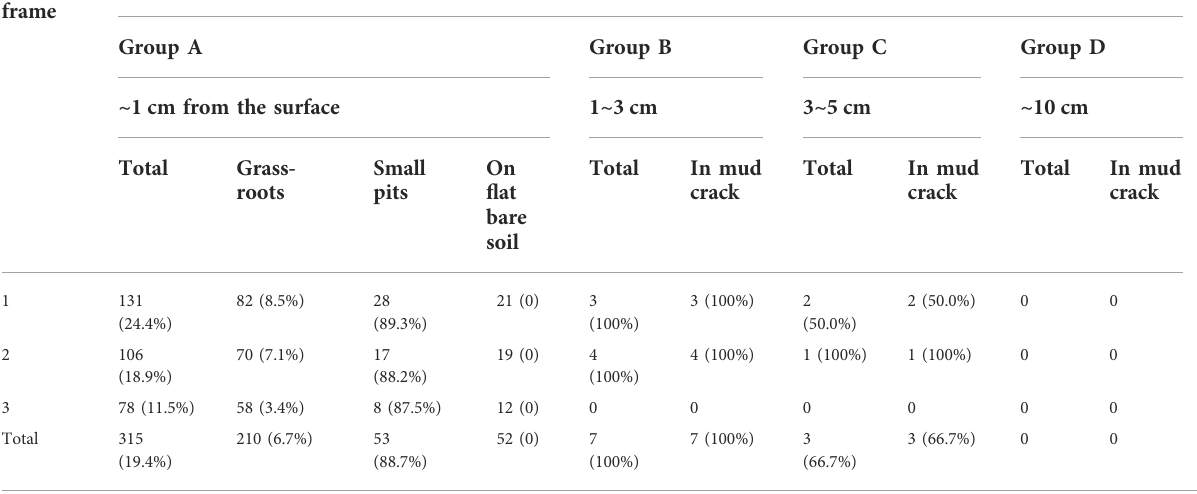
Cohesive granular